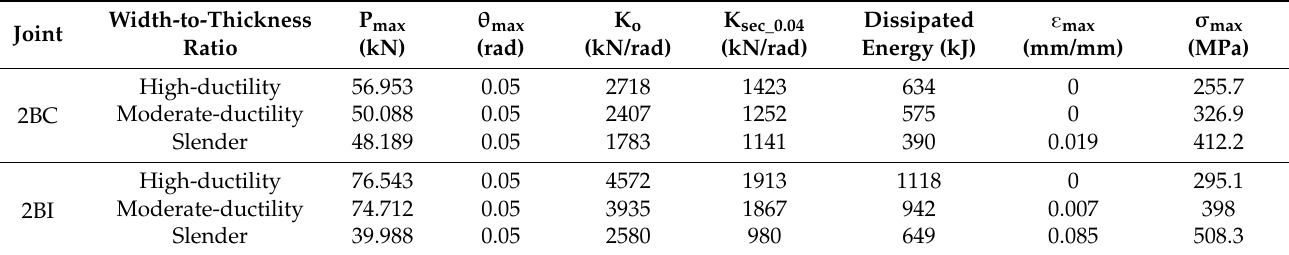
Table 5. Summary of the parameters obtained in numerical